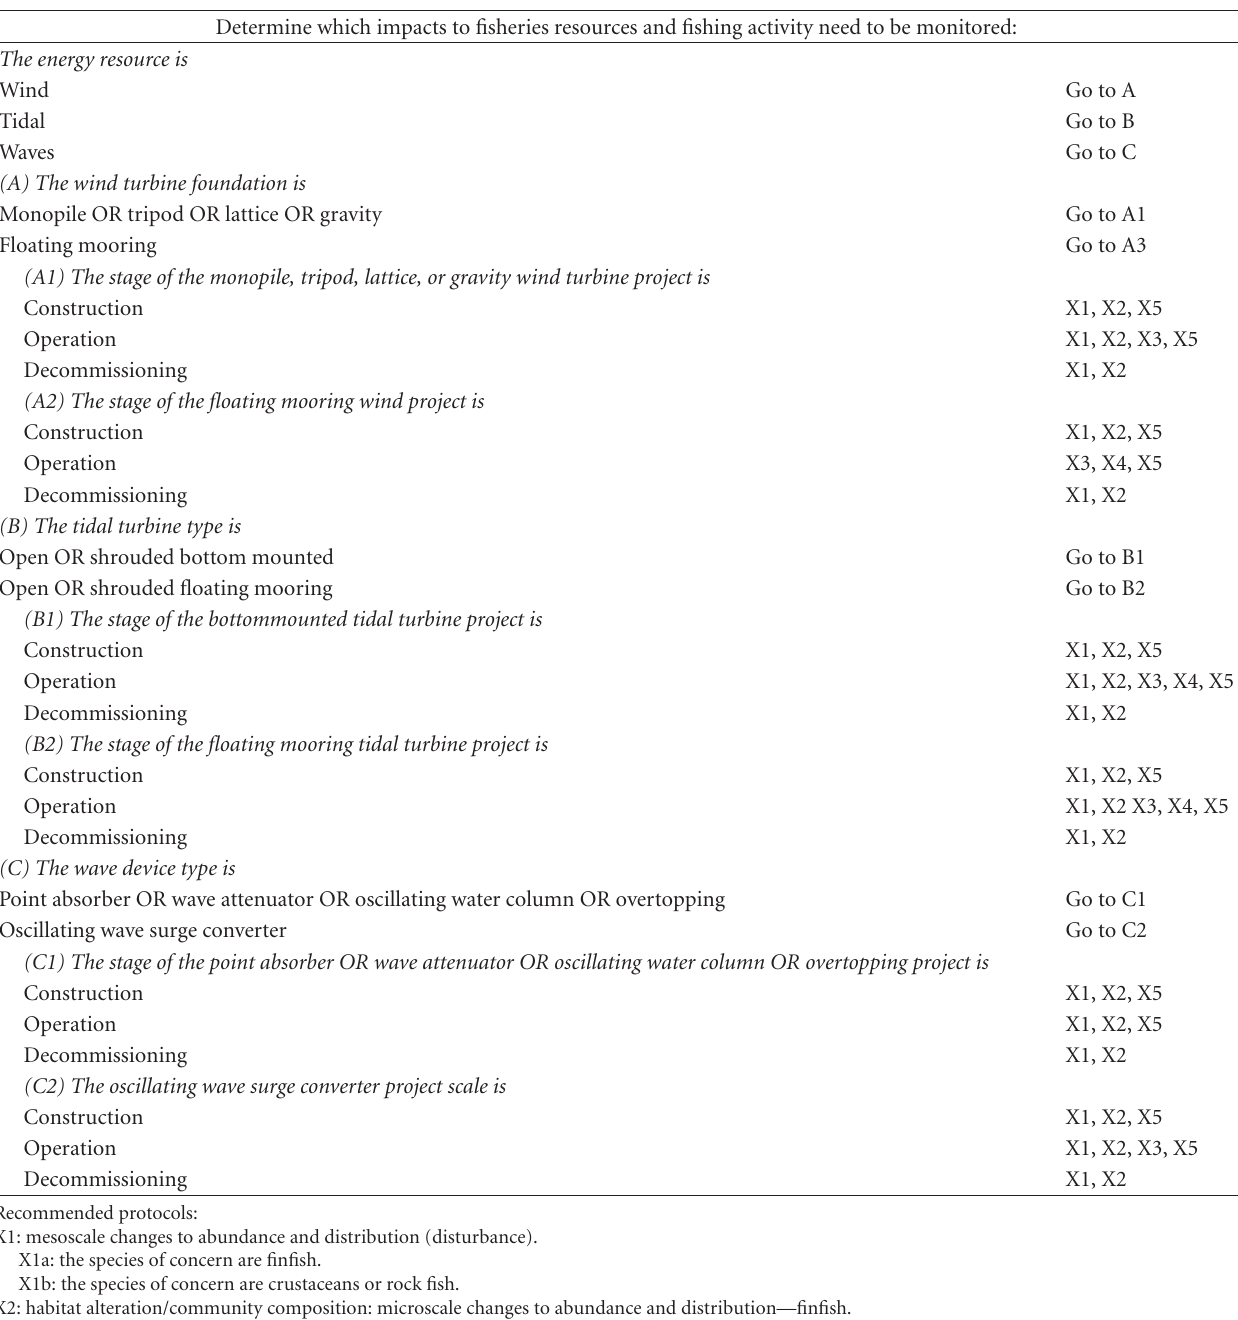
Table 10: Component decision tree for impacts on fish species and fisheries. The key is followed to obtain a recommended suite of monitoring